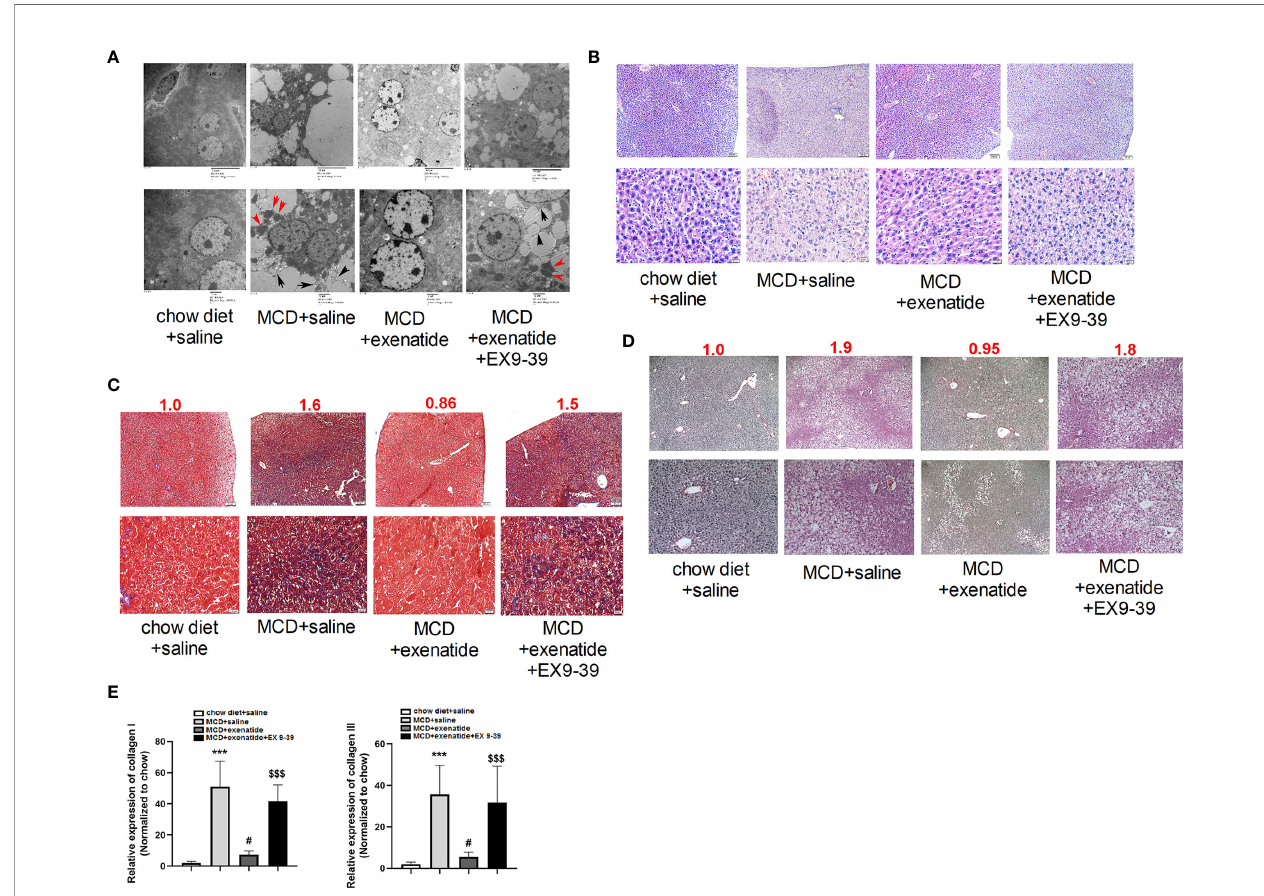
FIGURE 3 | Exenatide inhibited fi brosis in a NASH mouse model. (A) Representative electron microscopy images showing pyroptosis bodies (red arrows) and membrane rupture (black arrows) in NASH mice liver tissue and exenatide inhibitor treated mice. Exenatide treatment reversed the phenotypes. (B) Representative liver tissue images stained by hematoxylin and eosin. The pathological features of NASH were observed in MCD and MCD+Exenatide+Ex9-39 groups, such as nuclear rupture, increased cell area, and disordered arrangement. (C) Representative liver tissue images after Masson staining. The numbers above each picture (shown in red) indicated the relative staining intensity as quanti fi ed by ImageJ. (D) Representative liver tissue images stained by Sirius Red. (E) RT-qPCR analysis of the expression of collagen I and collagen III in mice liver tissues. ***p < 0.001 vs. chow diet + saline; ### p < 0.001 vs. MCD + saline; $$$ p < 0.001 vs. MCD + exenatide (n = 5 – 6). Data are expressed as the mean ±